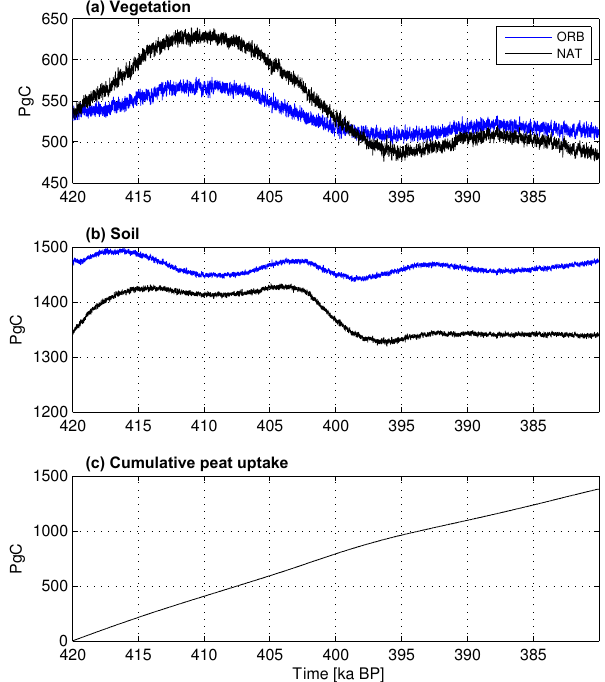
Figure 11. Disaggregation of the net carbon fluxes in the MIS 11 experiments: geological flux to atmosphere (a) , land–atmosphere flux (b) and ocean–atmosphere flux (c) . Plots have been smoothed for clarity.